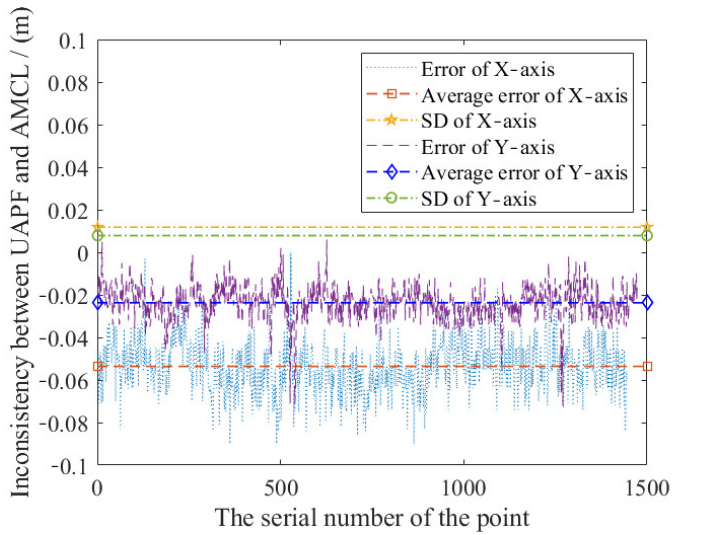
Figure 10. The stability in both X and Y directions. Average errors are both within 0.05 m and the standard deviation (SD) is less than 0.01